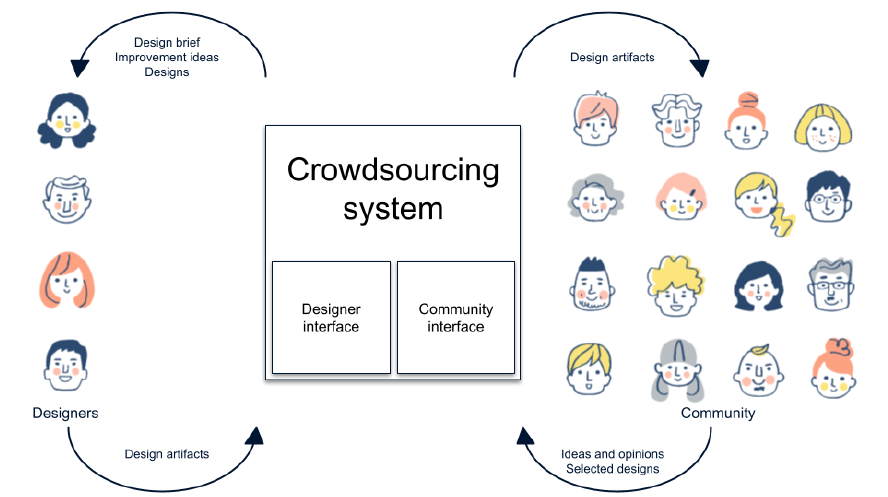
Figure 1. The negotiation crowdsourcing model involves the system providing tasks to the commu- nity, with the goal of collecting their insights and ideas through natural language. This input is then processed and assigned as a design task to multiple designers, who create a range of design solutions. These solutions are then presented to the community, allowing them to vote on their preferred option and provide